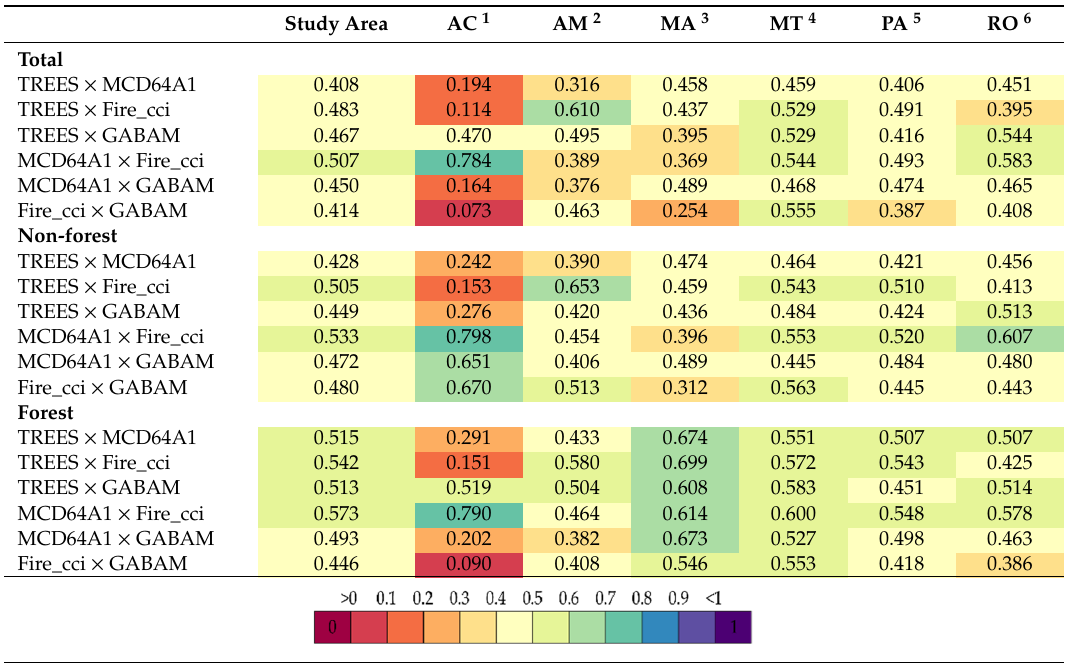
Table 3. Overall similarity for each burned area product comparison pair, considering the whole area, and separating it into non-forest and forest areas. The result is provided for the entire study area, as well as for each Brazilian state considered separately. The similarity index ranges from 0 (fully distinct) to 1 (fully identical), and was calculated using the fuzzy numerical algorithm for map